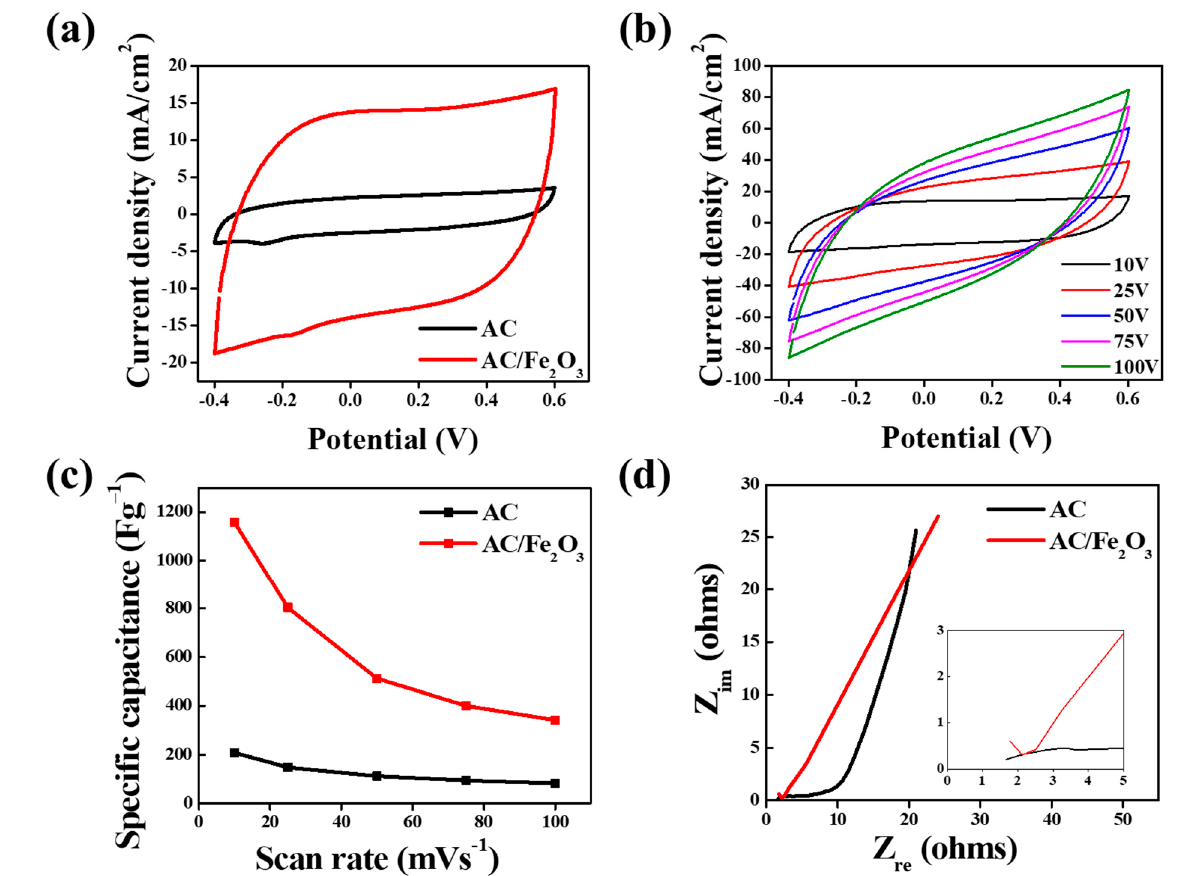
Figure 6. CV curves ( a ) for the proposed electrodes and ( b ) for the AC/Fe 2 O 3 electrode at various sweep rates. ( c ) Specific capacitance for the electrodes and ( d ) Nyquist plot for the electrodes in a 1 M NaCl aqueous solution.